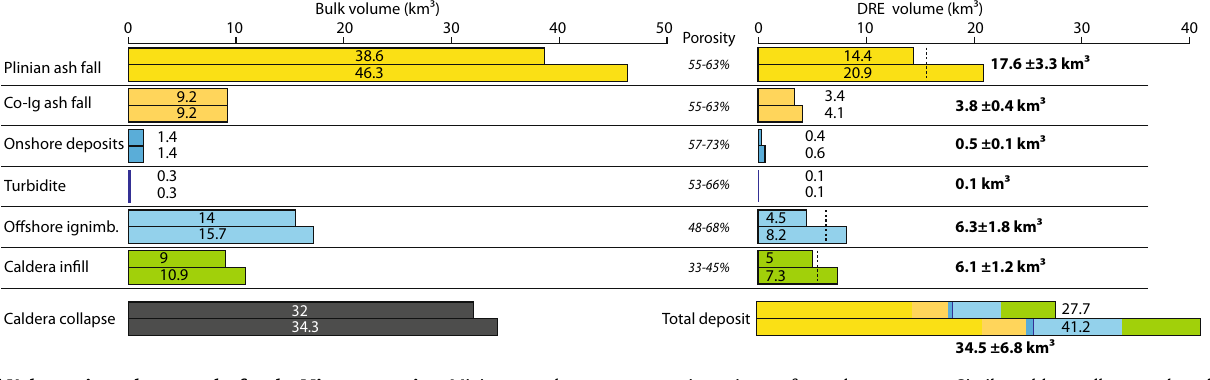
on porosityestimatesforeachcomponent. Similar calderacollapseand totalDRE- volumes indicate an internal